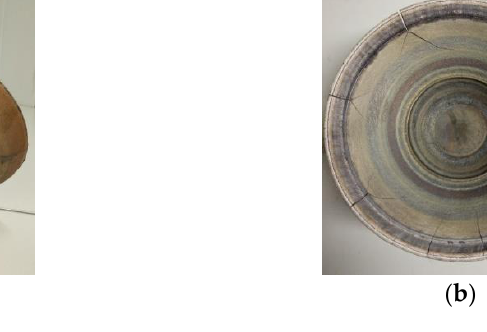
Figure 2. The appearance of the "defective" details: (a) No. 1; (b) No. 2.